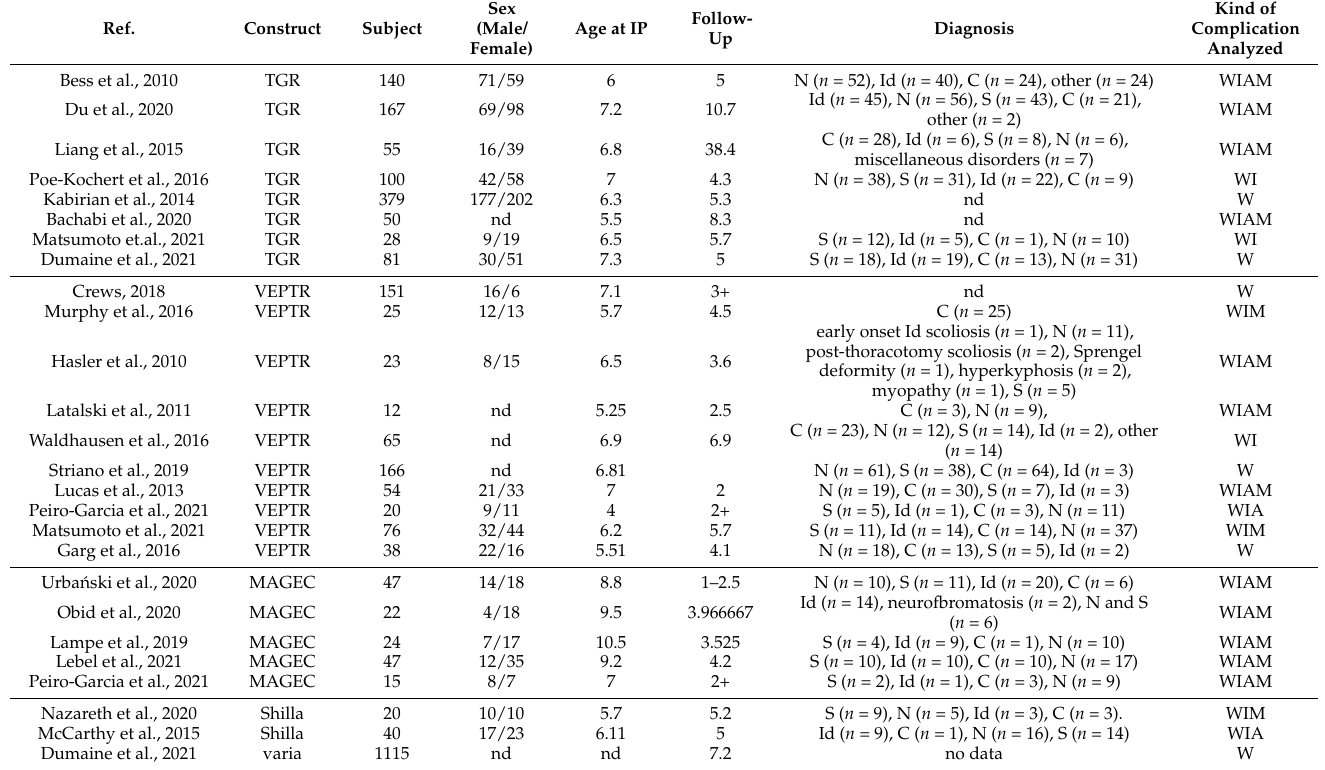
Table 1. Demographic data from the reviewed articles. Diagnosis: Neuromuscular (N), Idio- pathic (Id), Congenital (C), Syndromic (S), nd—no data. Type of complications: Wound (W), implant-related (I), alignment (A), and medical/surgical complications (M). GGS—Growth guid- ance system; VEPTR—Vertical expandable prosthetic titanium rib; TGR—Traditional growing rod; MAGEC—MAGnetic Expansion